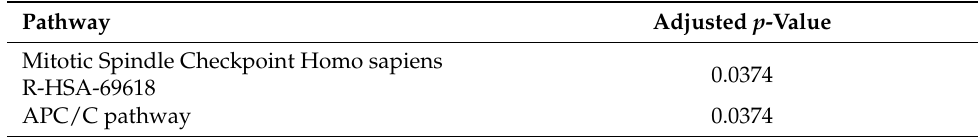
Table 5. Enrichment analysis ranking pathways based on significant overlaps between given genes and annotated gene sets.